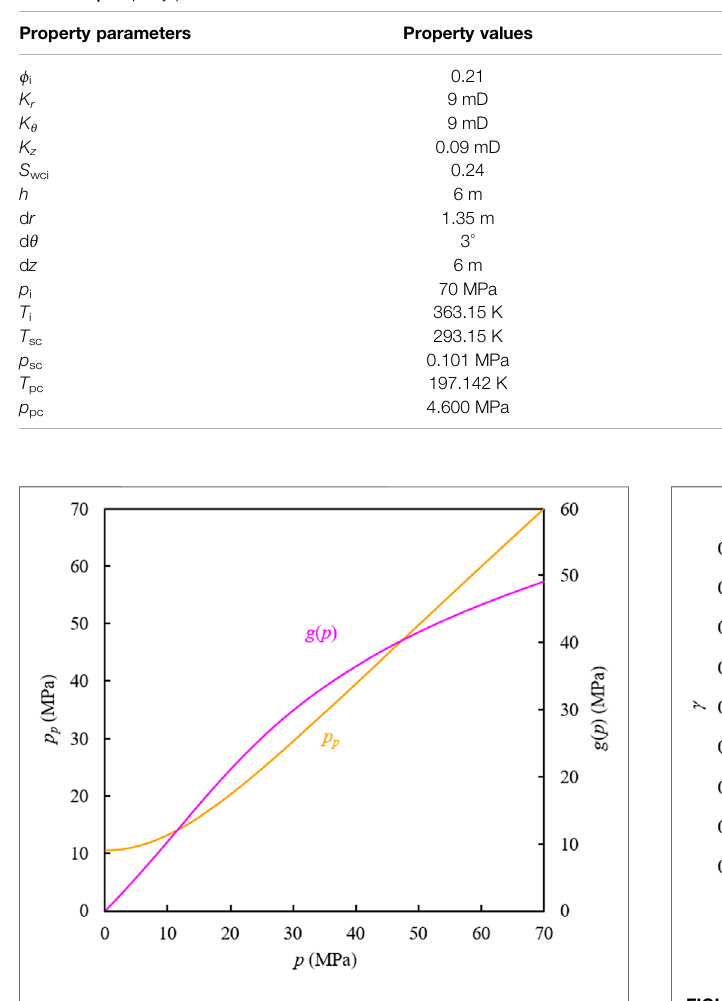
FIGURE 4 | p p and g ( p ) vs. p for numerical cases. FIGURE 5 | c and ε vs. R for numerical